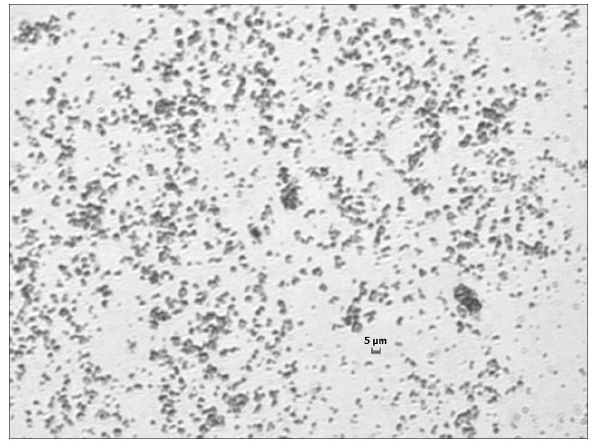
Figure 2. The image of TiO 2 NPs aggregates in saline under the light microscope. TiO 2 NPs in saline solution was dropped onto a glass slide and the aggregates of TiO 2 NPs in solution was checked under the microscope (400 6 ). After precipitation, the larger aggregates were in the size range of 100–500 nm, and the smaller aggregates were not visible under the light microscope at 400 6 .